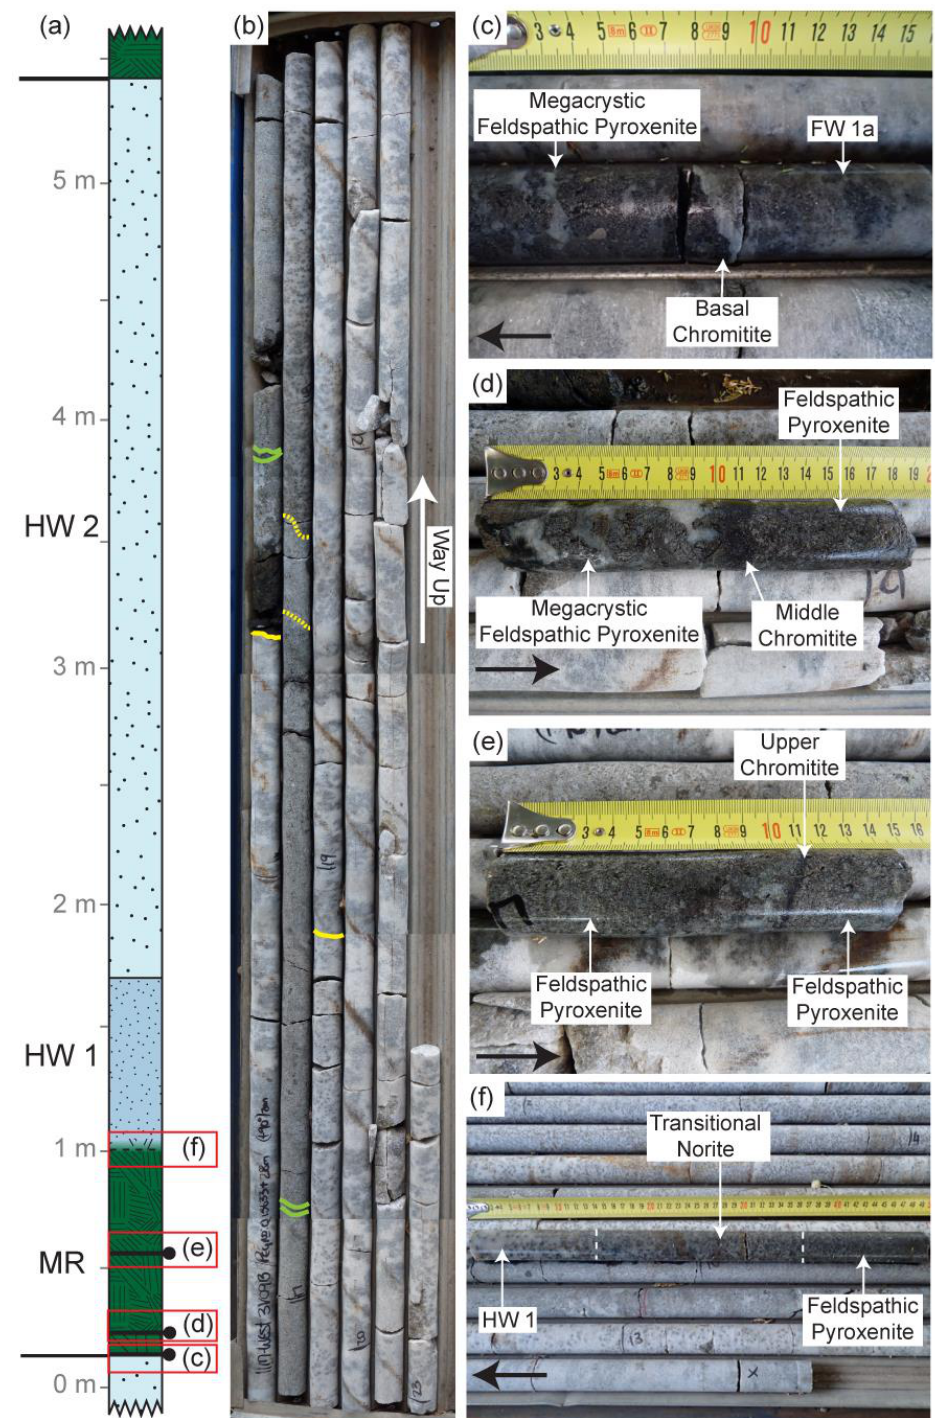
Figure 3. ( a ) Sketch of drill core through the Merensky Unit from FW1a to BU; ( b ) Photograph of the drill core, green lines denotes the positions of chromitites, yellow lines indicate contacts between layers and dashed lines are gradational contacts; ( c – f ) Closer views of contacts outlined in ( a ), black arrows indicate the way up. ( c ) Basal contact of Merensky Unit with underlying poikilitic anorthosite of FW 1a, contact is marked by the basal chromite and overlain by megacrystic feldspathic pyroxenite; ( d ) Merensky Reef middle chromite between underlying megacrystic feldspathic pyroxenite and overlying feldspathic pyroxenite; ( e ) Merensky Reef upper chromitite sandwiched between feldspathic pyroxenite; ( f ) Transitional contact between feldspathic pyroxenite and overlying leuconorite of HW 1.